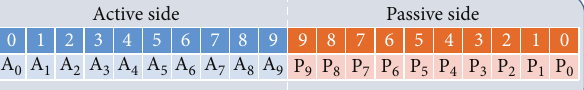
Figure 13: Parameter FD.